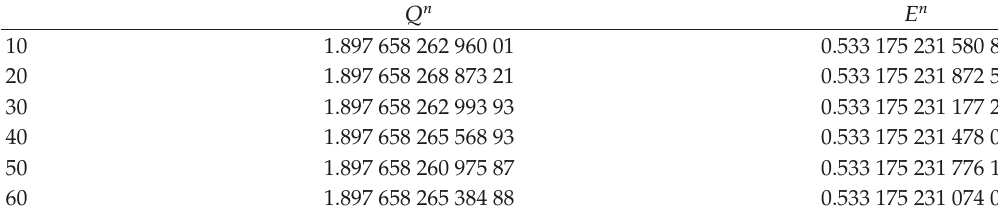
Table 4: Discrete mass Q n and discrete energy E n with τ (cid:7) h (cid:7) 0 . 1 at various t for p (cid:7) 2.